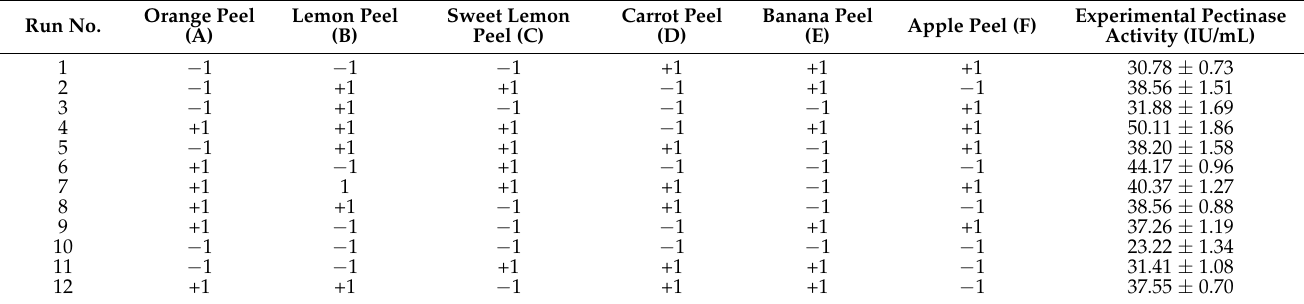
Table 5. The PB design matrix for carbon sources with the response.